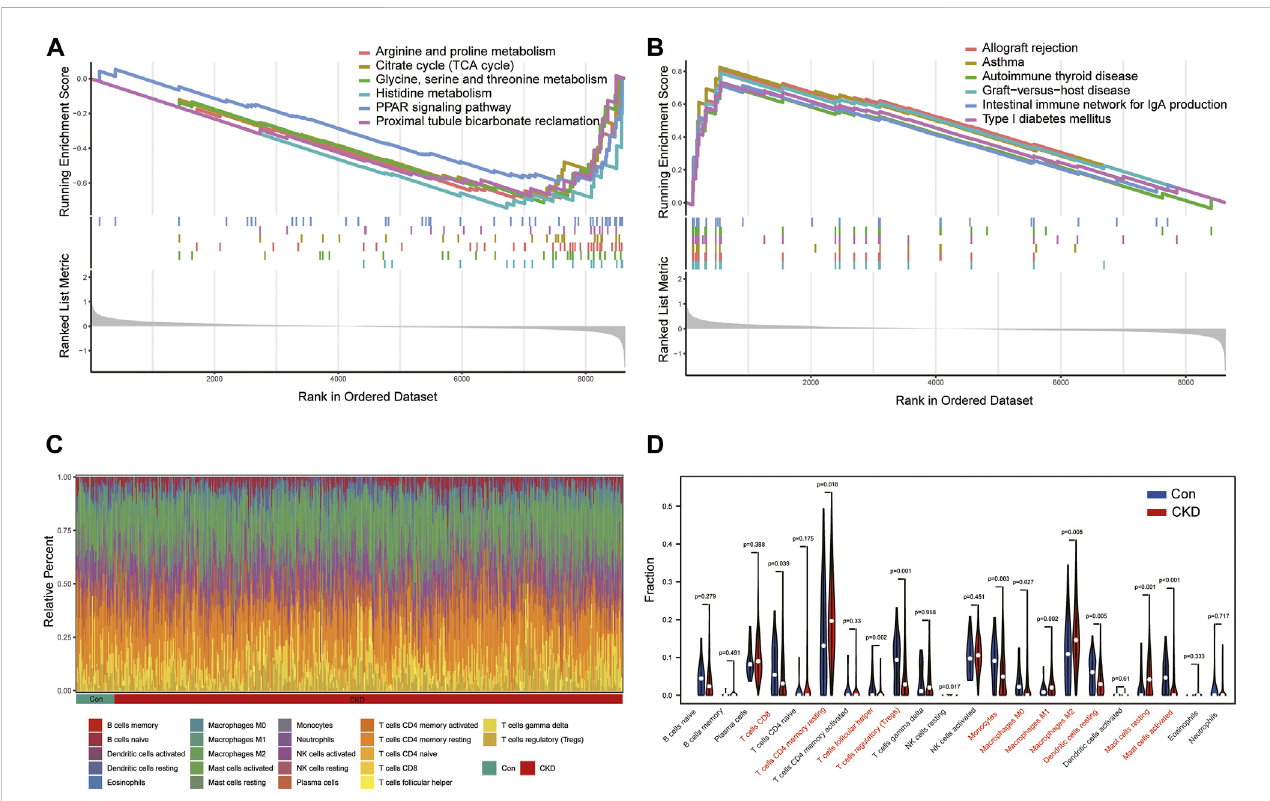
FIGURE 3 Analysis of GSEA enrichment and immunoin fi ltration among the normal and CKD patients (A) Six enriched KEGG pathways in normal samples. (B) Six enriched KEGG pathwaysin CKD samples. (C) Barplot of the relative frequency of 22 different immune cell in fi ltration in normal and CKD samples. (D) Vioplot of the difference of 22 different immune cells in normal and CKD